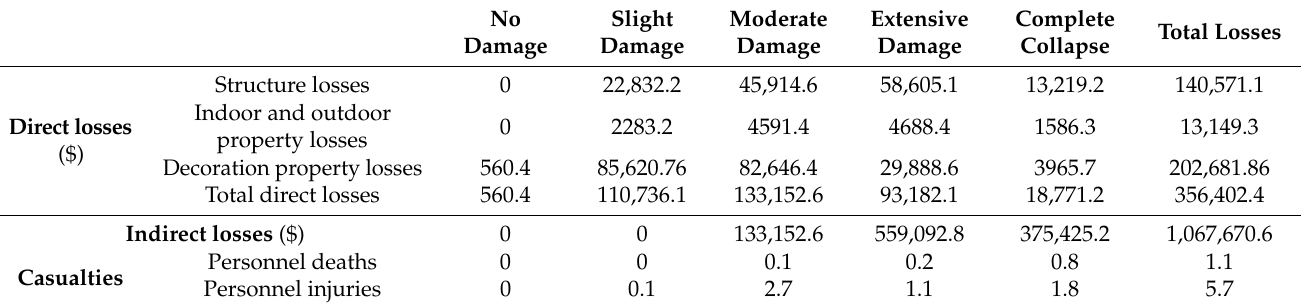
Table 13. Seismic risk assessment results.